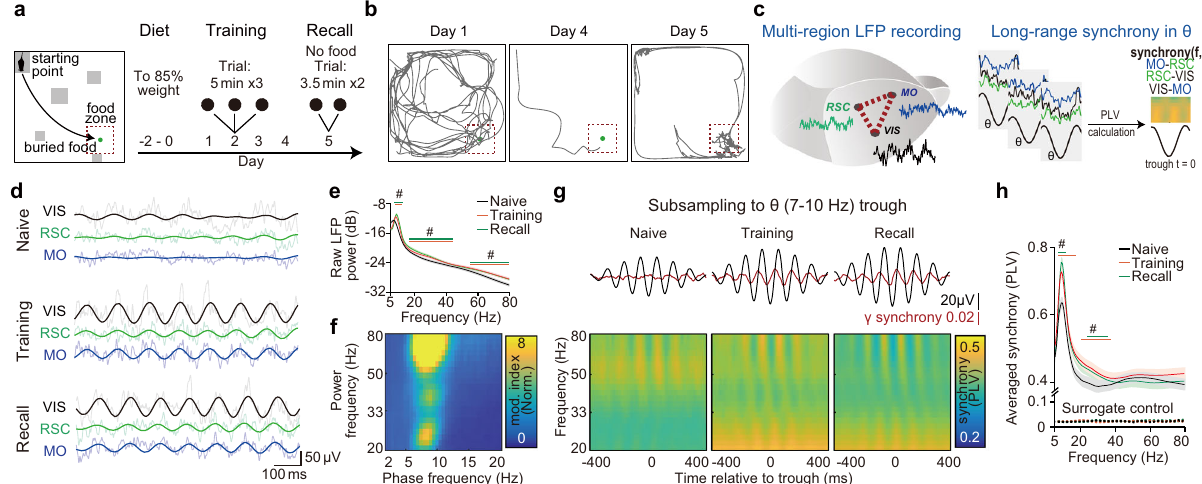
Fig. 1 Learning-induced cortical long-range gamma synchrony is coupled to the theta rhythm. a A schematic of the spatial memory task. Mice were trained to fi nd the place of hidden food (buried in sands) for 4 days. Recall trials were set on day 5 without any food reward. The arena was designed with landmarks (gray blocks) and buried food (green dot). Mice start exploring from the starting point in all trials. b Representative trajectories of one mouse during learning and recall. c Simultaneously recording of LFPs from three distinct cortices during the task (left) and calculation of phase-synchrony spectrogram by subsampling LFPs to theta trough (right). d Representative LFP raw traces (tint lines) and fi ltered traces (theta ( θ ) band, 7 – 10 Hz, dark lines) from three recording sites at different stages of the task. Here training shows the data from the fi rst day of training, same as the following graphs. See results for each region for each day in the supplementary Fig. 1c. e, f Theta and gamma power increased in training/recall trials and the gamma power was coupled to cortical theta phase (78 electrodes from 28 mice, N MO = 26, N RSC = 26, N VIS = 26). e Averaged raw cortical LFP power from three regions of different trials. Encoding showed here is data from training day1. Signi fi cance was assessed by two-way ANOVA followed by false discovery rate (FDR) corrected multiple comparisons at each frequency comparing with data of homecage trail. The trial factor but not the frequency factor was repeatedly measured. Statistical signi fi cant frequency range ( q < 0.05) is noted on the graph in corresponding colors. f Phase-power modulation index comodulograms of training, averaged from all regions. (See comodulograms of each region for each day and corresponding quanti fi cation in Supplementary Fig. 3). Modulation index was normalized by the element-wise division of the raw comodulogram by surrogated control. g, h Theta and gamma synchrony elevated in training/recall trials and the gamma synchrony was coupled to cortical theta phase (72 electrode pairs from 28 mice. N MO-RSC = 24, N RSC-VIS = 24, N MO- = 24). g Gamma synchrony was speci fi cally coupled to theta phase during training and memory recall. Top, averaged theta wave (black) and 30 Hz VIS cortical synchrony (red). Bottom, averaged phase(theta)-synchrony(gamma) spectrogram from all pairs. Each pixel of the spectrograms showed averaged synchrony of all pairs. h Comparison of averaged overall synchrony in three kinds of trials (See result for each pair for each day in the supplementary Fig. 1d. q < 0.05, FDR corrected, signi fi cantly changed frequencies were noted on the graph). # q < 0.05, Shadow of line plot shows